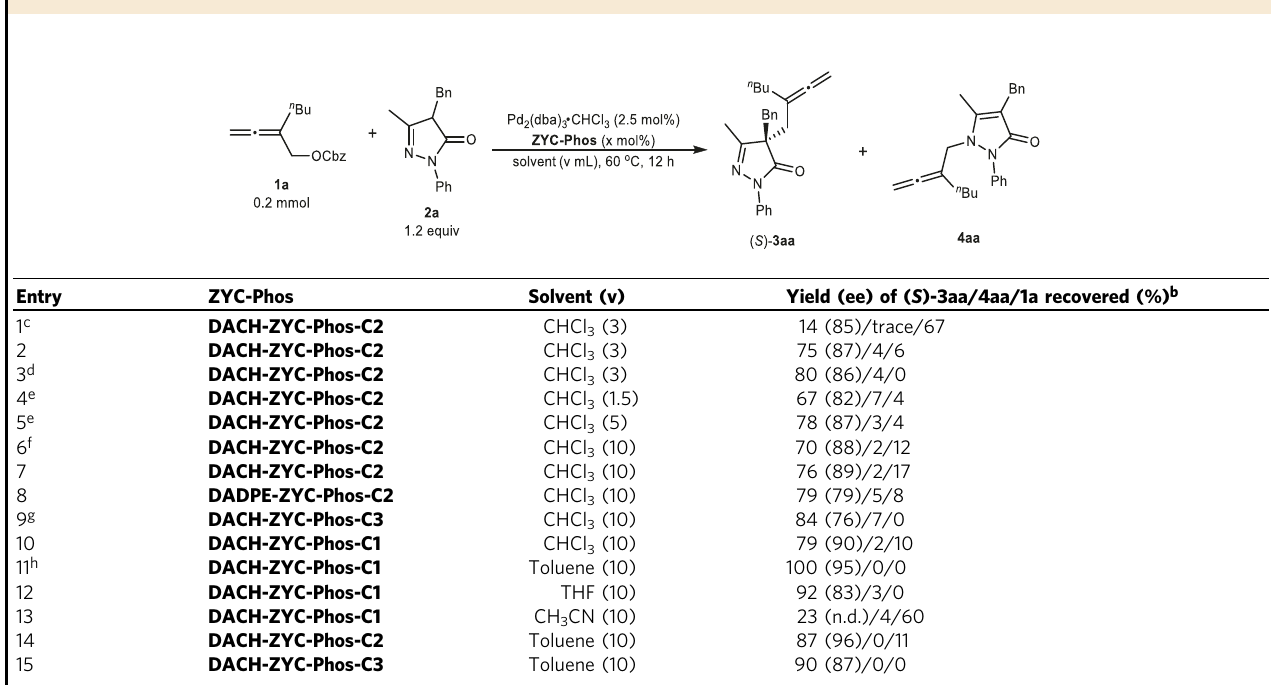
Table 1 The effect of temperature, concentration, ligands, and solvents on the asymmetric allenylation of pyrazolone 2a with allene 1a a